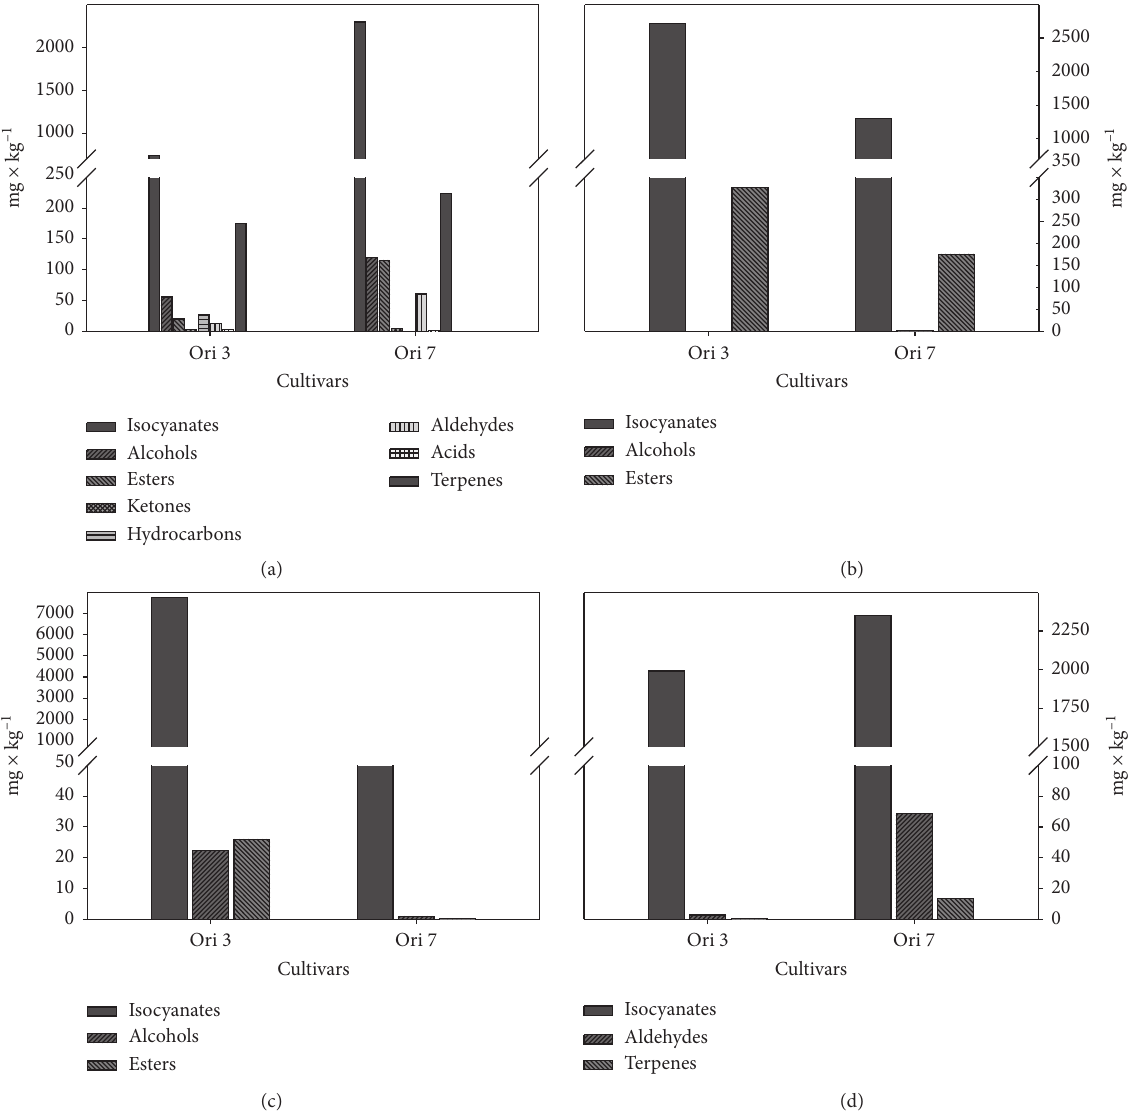
Figure 1: Identified families in both cultivars, “ORI3” and “ORI7,” in the aerial parts of Capparis spinosa L. expressed in mg · kg − 1 of fresh weight of flowers (a), leaf and stems (b), flower buds (c), and caper fruits